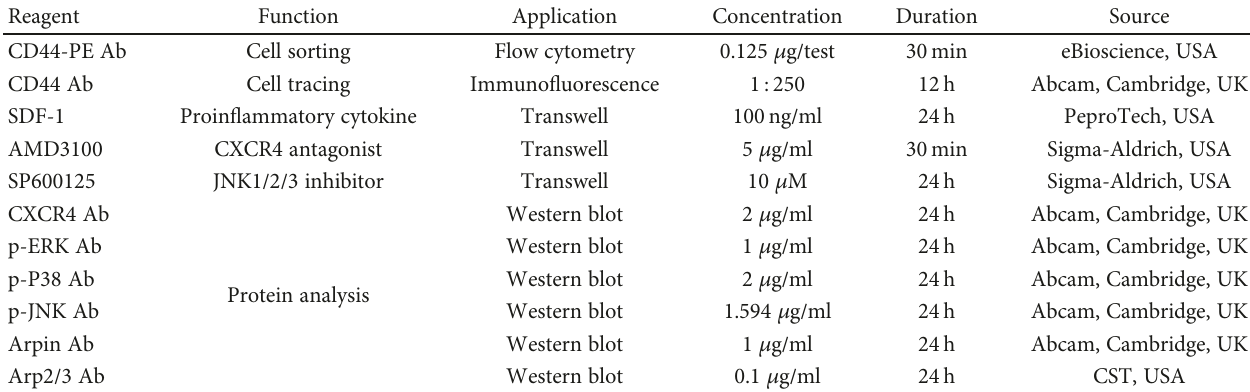
Table 3: Reagents used for in vitro